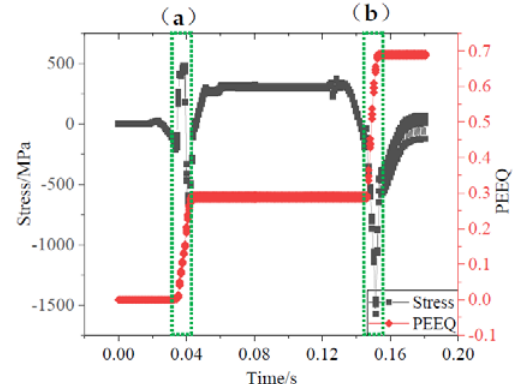
Figure 7. ( a ) Changes in stress and strain with time for a strip with a 0.25 mm grinding depth (first pass); ( b ) changes of stress and strain with time for a strip with a 0.5 mm grinding depth (first pass). Figure 8. Changes in stress and strain with time for a strip with a 0.75 mm grinding depth, showing deformation of ( a ) first and ( b ) second passes.